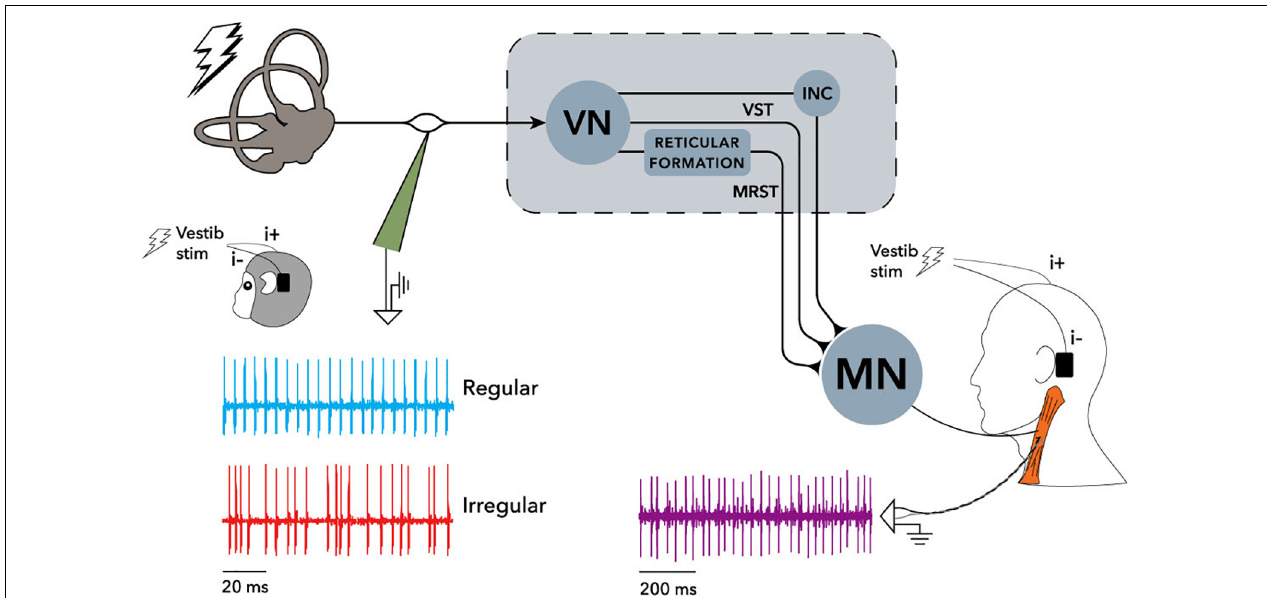
FIGURE 2 | Recording arrangement and neural pathways of the electrically evoked vestibulo-collic reflex in monkey and human, reproduced from Forbes et al. (2020). Single motor unit recordings were made from the sternocleidomastoid muscle (SCM) using irregular stimuli, and sine wave stimuli at frequencies up to 300 Hz. Cervical motor unit activity in both human and monkey was modulated by the stimuli. Recording of vestibular afferents in the monkey only showed similar modulation. See Forbes et al. (2020) for detail of filtering and phase locking effects. When evaluated using surface electrodes and sound or vibration stimuli, inhibition of SCM spindles can be measured as the cervical vestibular evoked myogenic potential (VEMP) which is the subject of the current study. INC, interstitial nucleus of Cajal; MN, motoneurons; MRST, medial reticulospinal tract; VN, vestibular nuclei; VST, vestibulospinal tract. Creative Commons Attribution License